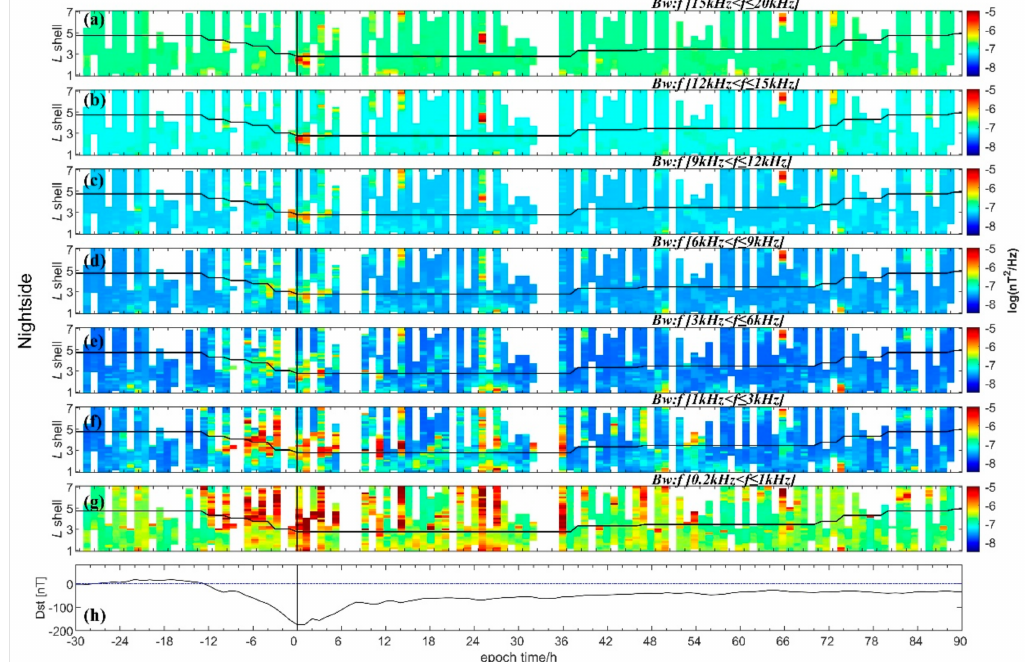
Figure 5. Same as Figure 4 but for the ELF/VLF wave intensities of the magnetic field in the nightside